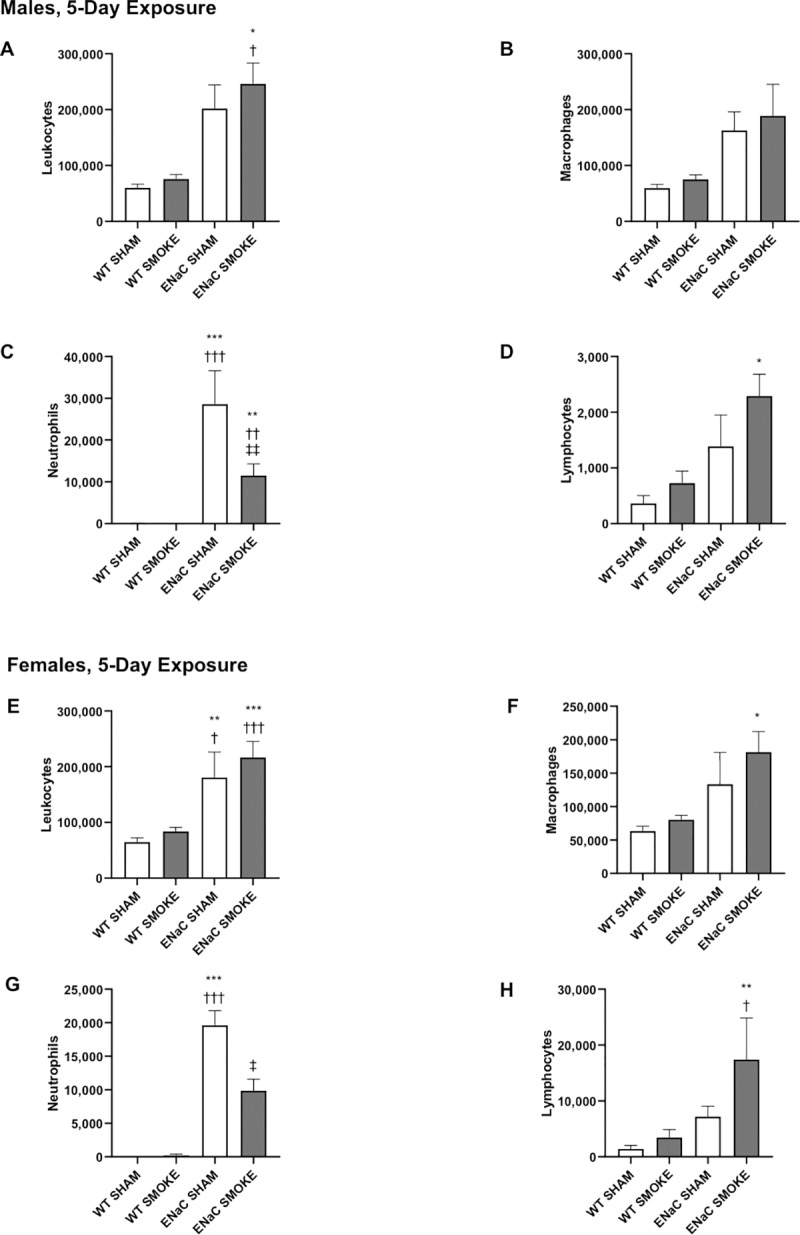
Effect of 5-day cigarette smoke exposure on BAL leukocyte numbers.The leukocyte counts in the BAL are described for males (A-D) and females (E-H) after 5-day sham or smoke exposure. A, E: leukocytes; B, F: macrophages; C, G: neutrophils; D, H: lymphocytes. Data are expressed as the total number of each leukocyte subtype in the BAL fluid. Analysis by ANOVA with Bonferroni’s post hoc test. Significance compared to (*) sham-exposed WT, (†) smoke-exposed WT, (‡) sham-exposed βENaC. Analysis by unpaired t-test: significance compared to (§) sham-exposed WT, (¶) smoke-exposed WT, (||) sham-exposed βENaC. Single symbols indicate p values < 0.05, double symbols indicate p values <0.01, and triple symbols indicate p values <0.001. Bars represent mean ± SEM.